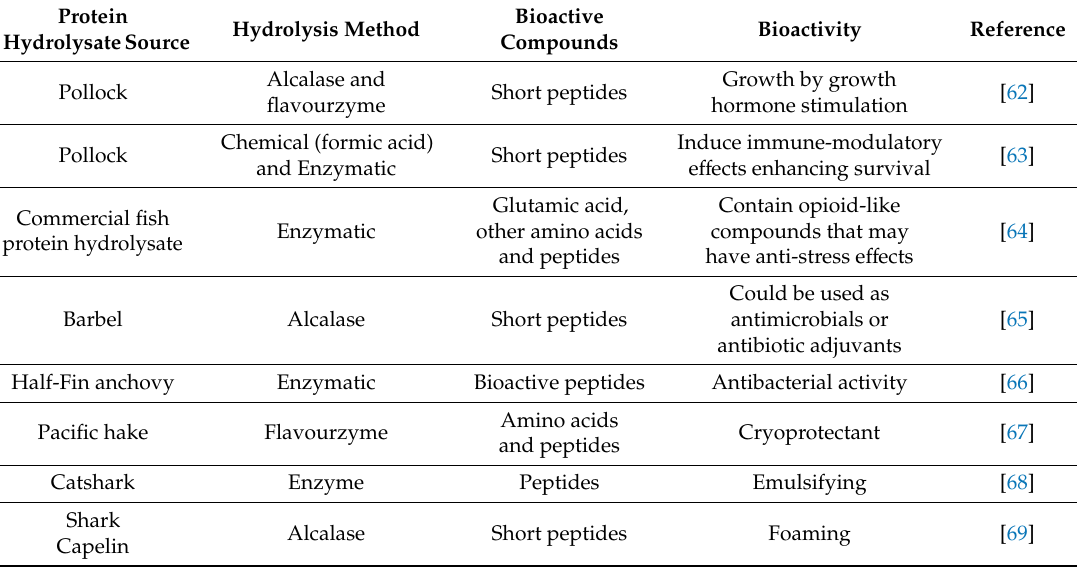
Table 3. Examples of fish protein hydrolysates used in animal feed supplementation and human